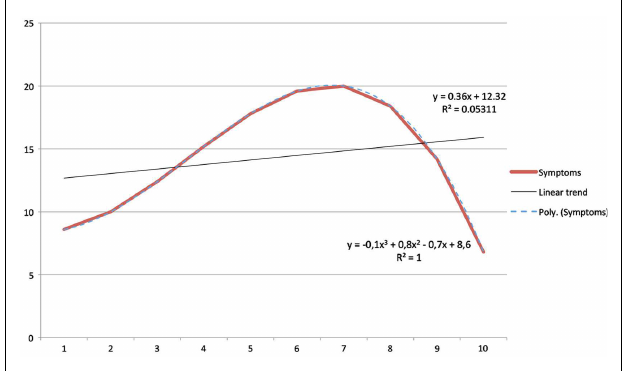
FIGURE 1 |An example of non-linear